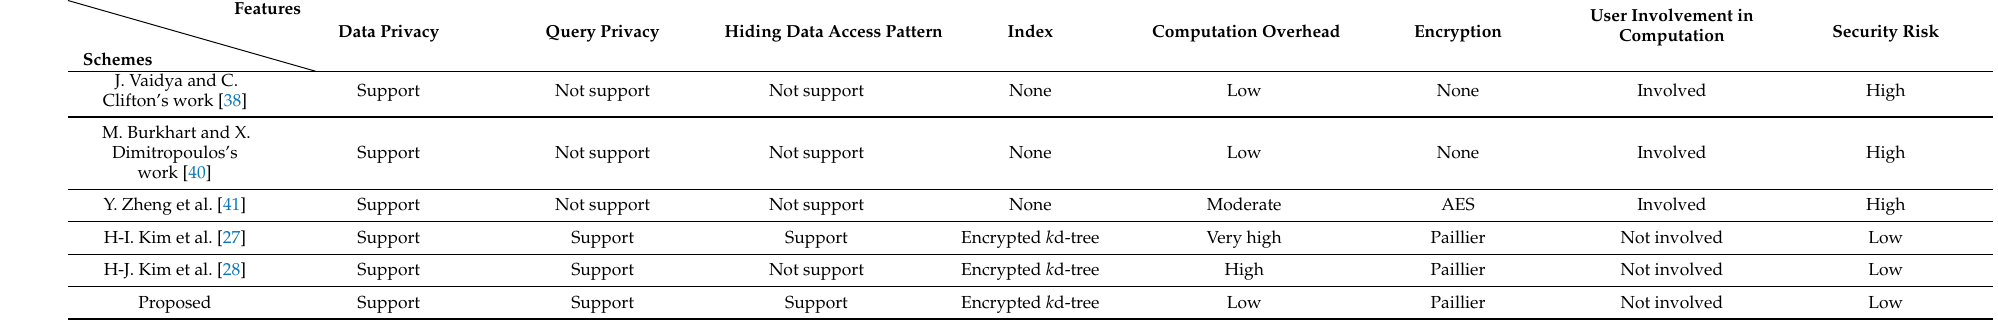
Table 1. Comparison of the existing